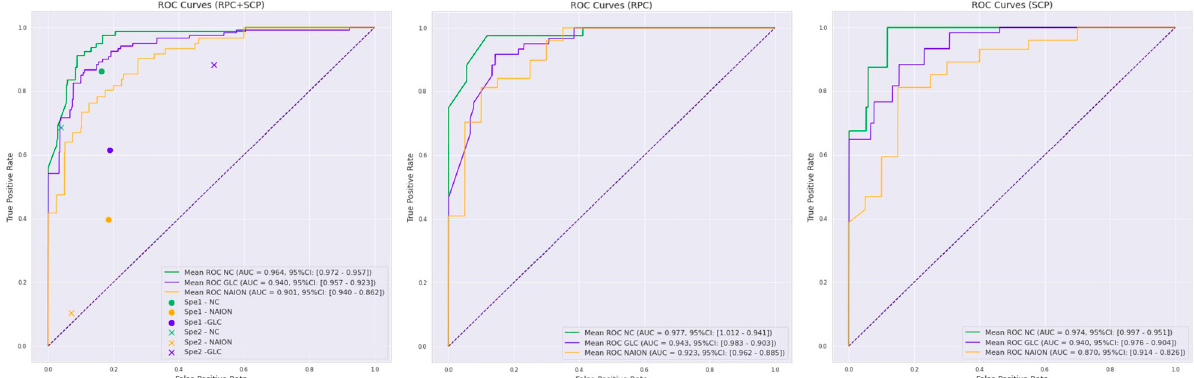
Figure 1. Receiver operating characteristics (ROC) curves for the three deep learning training protocols: mixed radial peripapillary capillaries plexus (RPC) + macular superficial capillary plexus (SCP) training, RPC training and SCP training. Normal control (NC, green curves), glaucoma (GLC, blue curves) and non-arteritic anterior ischemic optic neuropathy (NAION, yellow curves) corresponding to the mean ROC area under the curve (ROC-AUC) with a 95% confidence interval (95% CI) are indicated in the legend. Specialist 1 (Sp1) and specialist 2 (Sp2) performances are plotted on the RPC + SCP training curves for comparison.